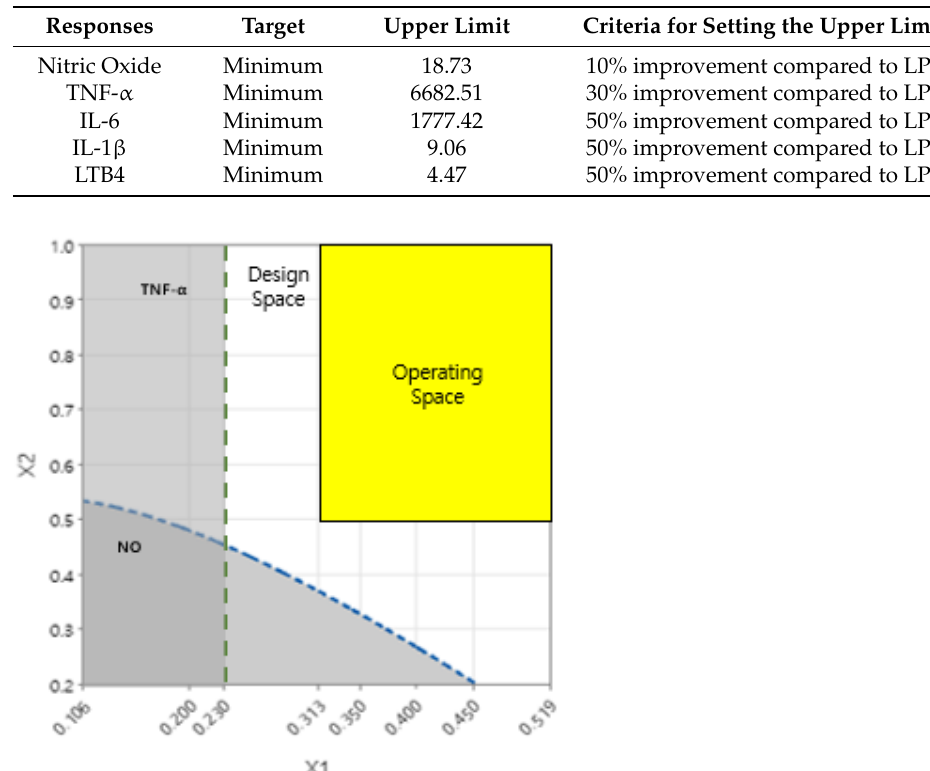
Table 7. Parameter of the output variables for DS.